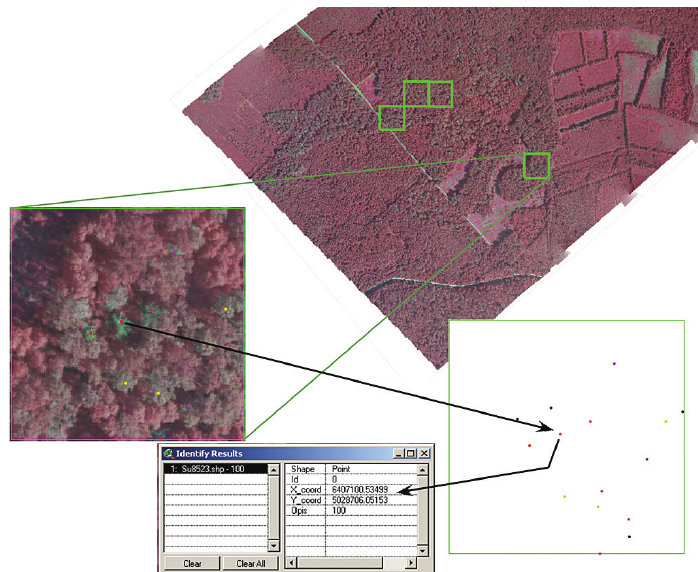
FIGURE 6. Excerpt from a surveying stripe (2008) with mapped trees in 1 ha samples (snags are marked red, and trees in damage degrees 3.1 and 3.2 are marked yellow and